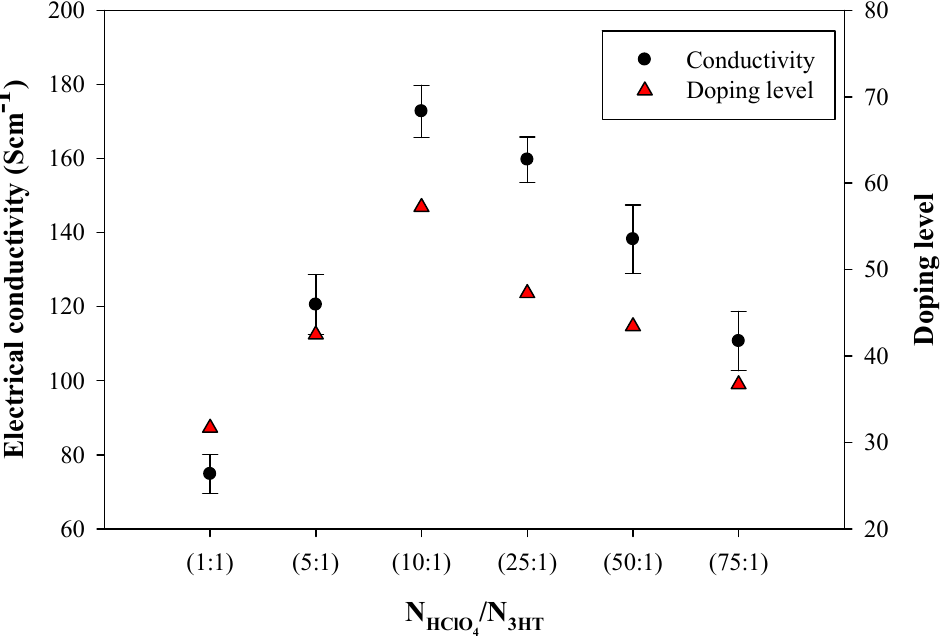
Figure 10. The relationship between the electrical conductivity and the doping level of P3HT (At the DBSA concentration of 6CMC) at various N HClO